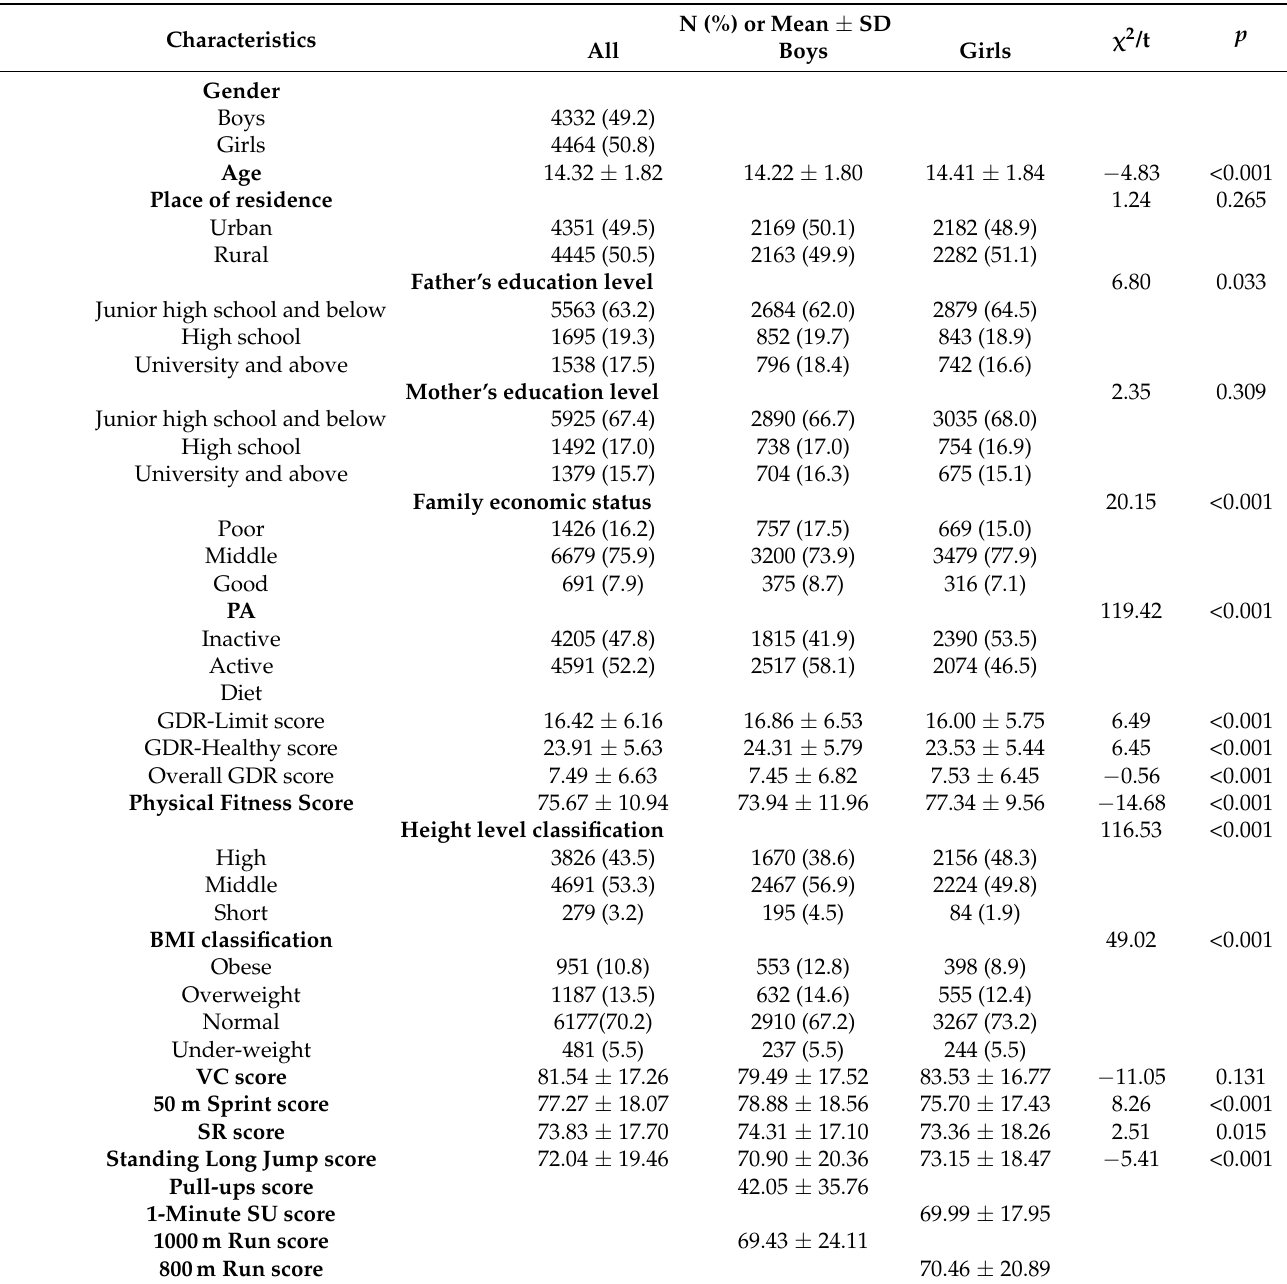
Table 2. Demographic characteristics of participants and differences between diet, PA and PF by participants’ gender, N =